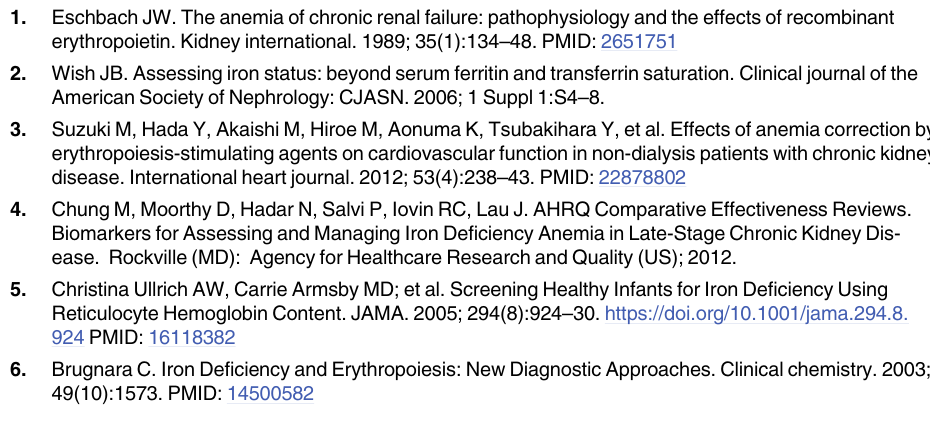
S1 Table. Combined model of performance of CHr and %HYPO. S2 Table. Association between gender and stage of kidney disease among non-dialysis CKD